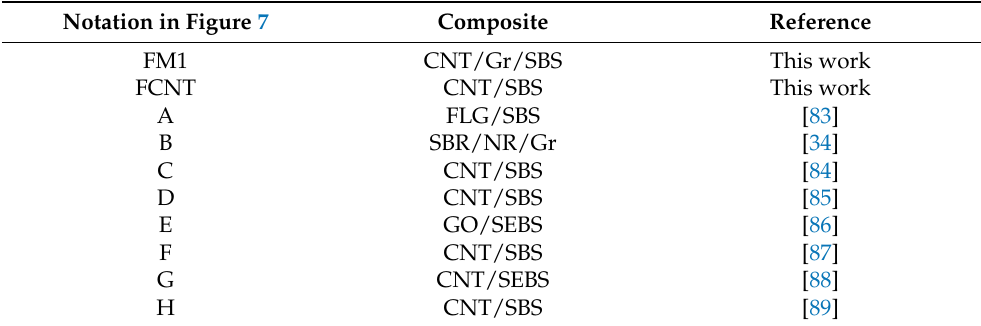
Table 3. The composition of reported in the literature piezoresistive composites with carbon fillers and polymer matrices from the styrene-butadiene